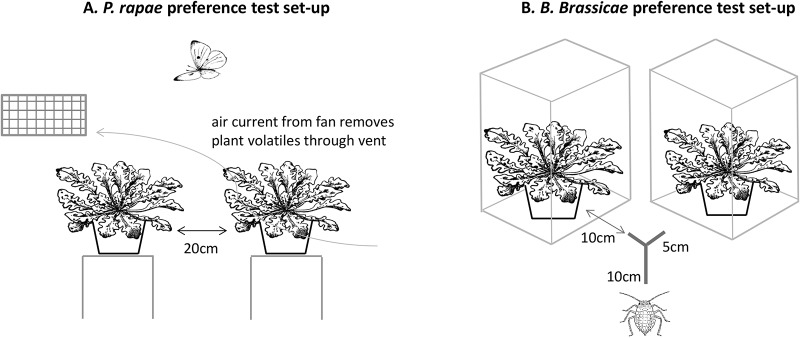
Experimental set-up of the herbivore preference experiments.(A) P. rapae responses to leaf colour were determined by recording landing responses of free-flying butterflies within a glasshouse. B. oleracea plants paired according to leaf colour were placed 20cm apart and on raised platforms 60cm from the ground. To remove plant volatiles, a fan blew air over the plants and out through a vent at the back of the glasshouse. (B) B. brassicae responses to leaf colour were determined by recording the choice made by aphids walking on a Y-stick. B. oleracea plants paired according to leaf colour were placed inside transparent plastic boxes against a plain white wall. Cling film was placed over the open side of the box facing the Y-stick to prevent aphids from detecting plant volatiles. At the start of each trial, an aphid was placed at the end of the 10-cm long arm of the Y-stick and allowed to walk towards the plants. Aphids were considered to have made a choice when they moved 1cm down one of the short 5cm arms.